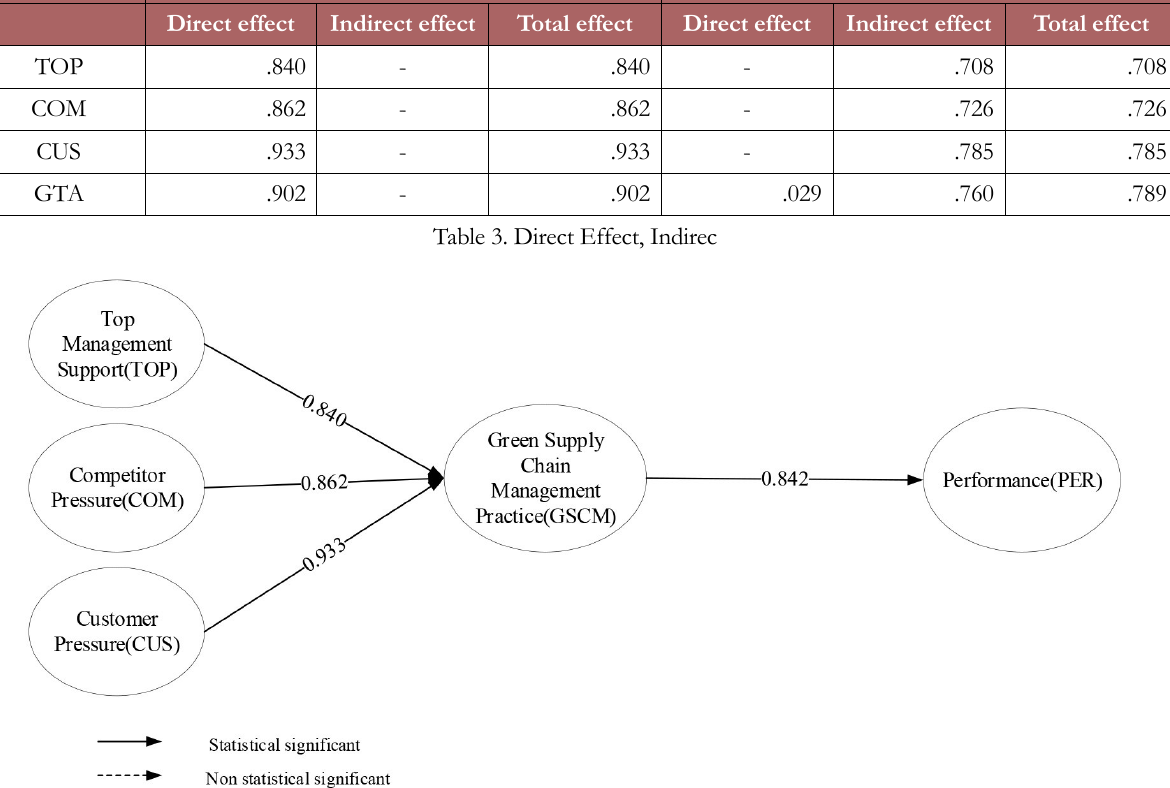
Figure 2. Results of the Structural Equation Model: Full